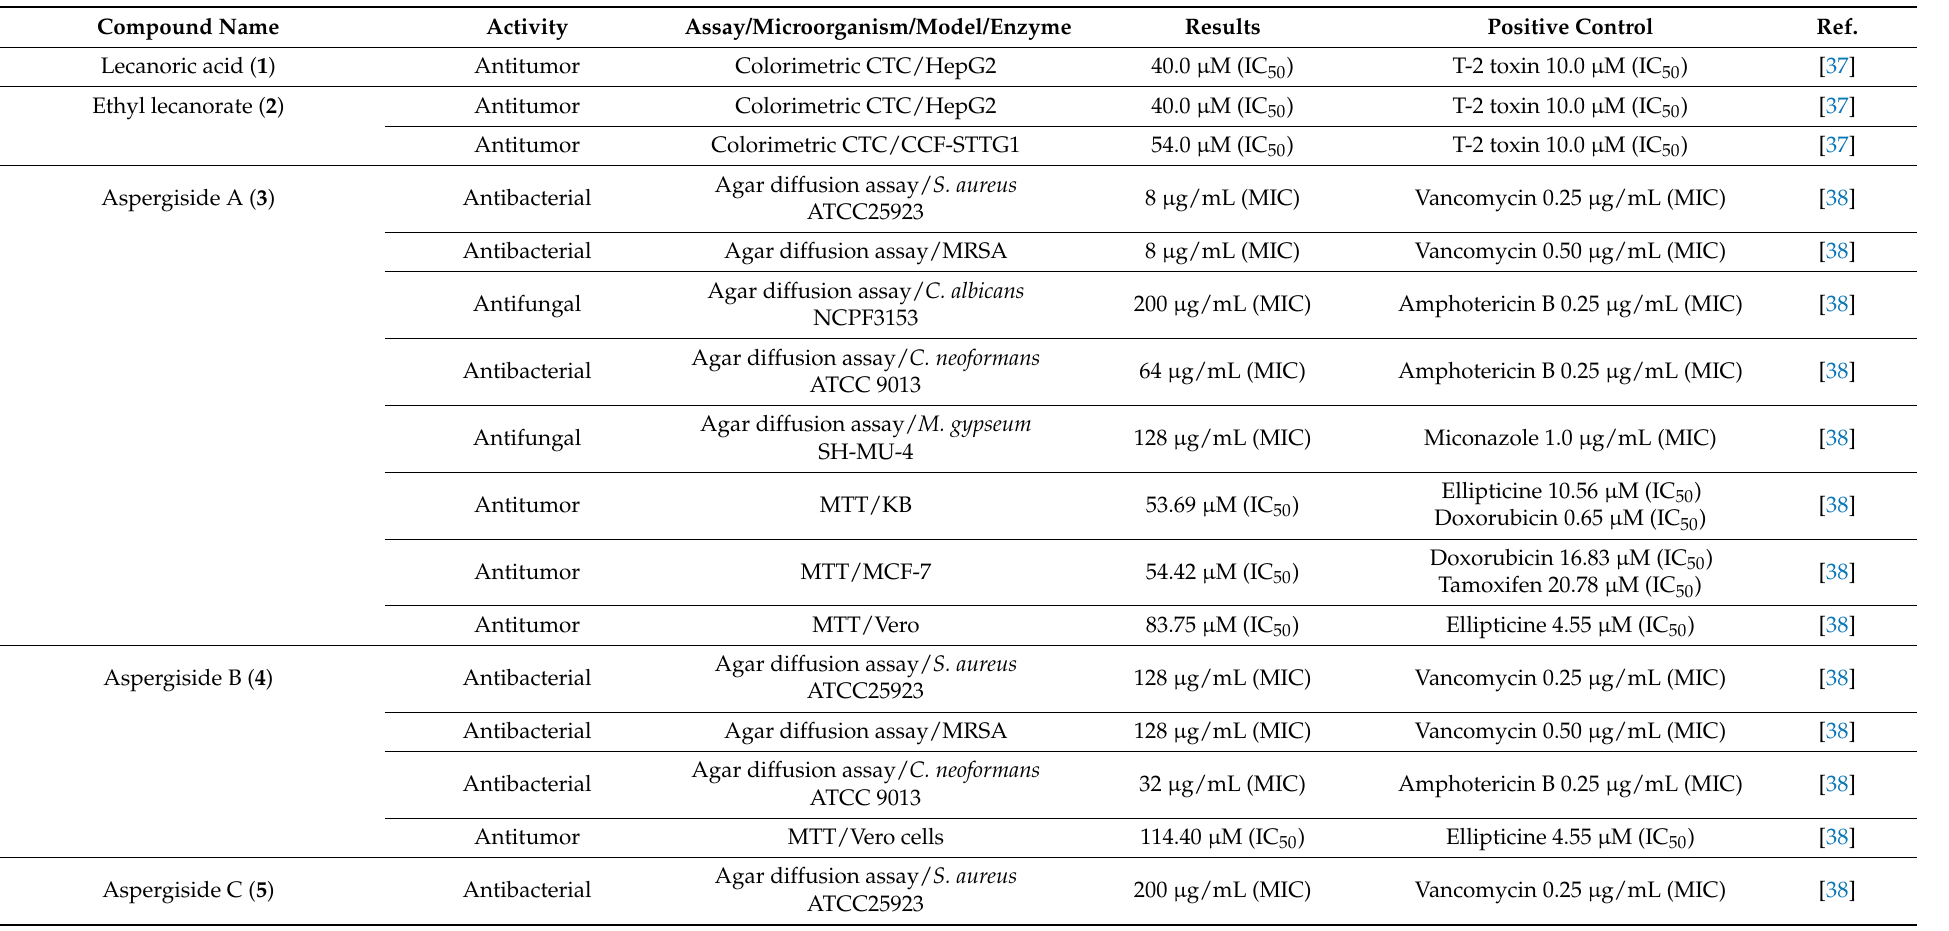
Table 2. Biological activities of fungal